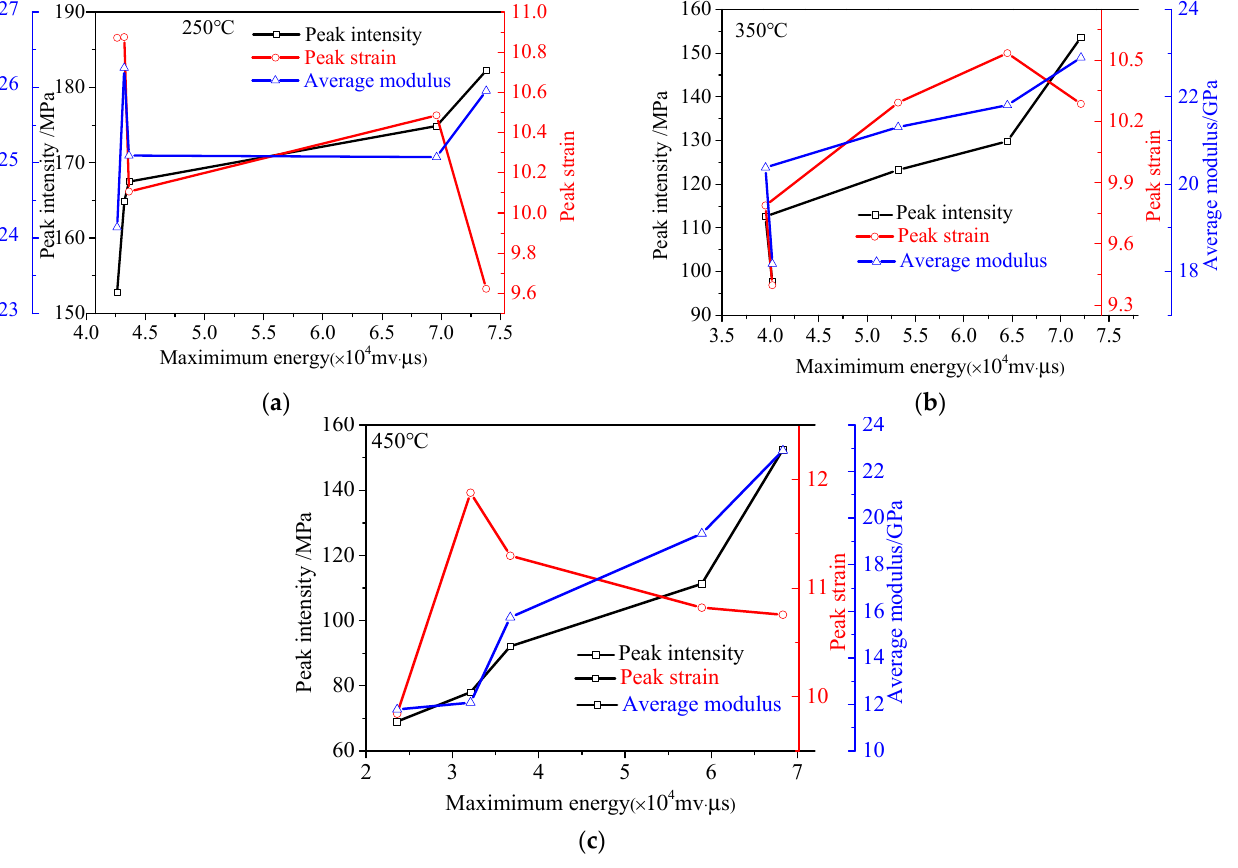
Figure 10. Relationship between the basic mechanical parameters of the specimen and the maximum energy of acoustic emission. ( a ) T = 250 °C. ( b ) T = 350 °C. ( c ) T = 450 °C.